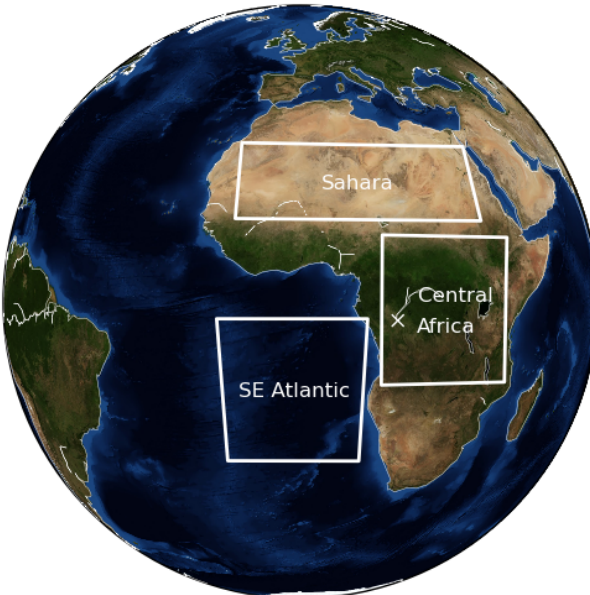
Figure 10. Map of the area observed by SEVIRI showing true- colour surfaces, major rivers, and lakes. Labelled boxes show the locations of the regions used in Fig. 11. The white cross shows the location of the data used in Fig.